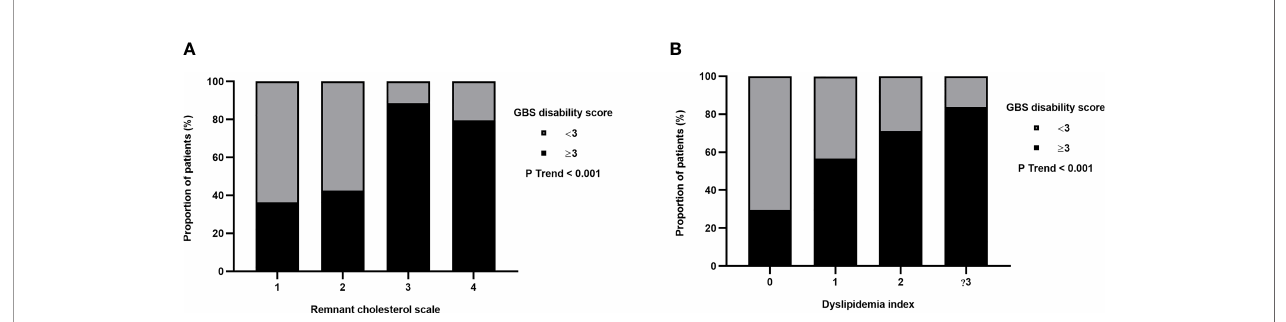
FIGURE 3 | Proportional distribution of severe GBS. (A) Remnant cholesterol scale was set according to the quartile levels of the enrolled GBS patients. The proportion of severe GBS tended to increase with increasing remnant cholesterol levels. (B) The proportion of severe GBS tended to increase with an increase in the dyslipidemia